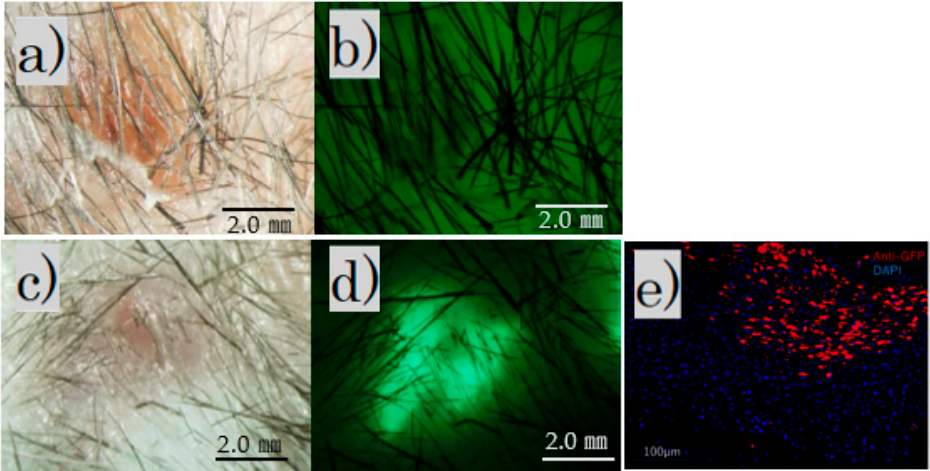
Figure 3. After irradiation for 4 weeks. Fluorescence microscopy: ( a ) control group, bright field; ( b ) control group, no fluorescence observed; ( c ) FB group, bright field; ( d ) FB group, fluorescence observed (scale bar 2 mm); ( e ) FB group paraffin section with immunofluorescence stained by an anti-GFP antibody.